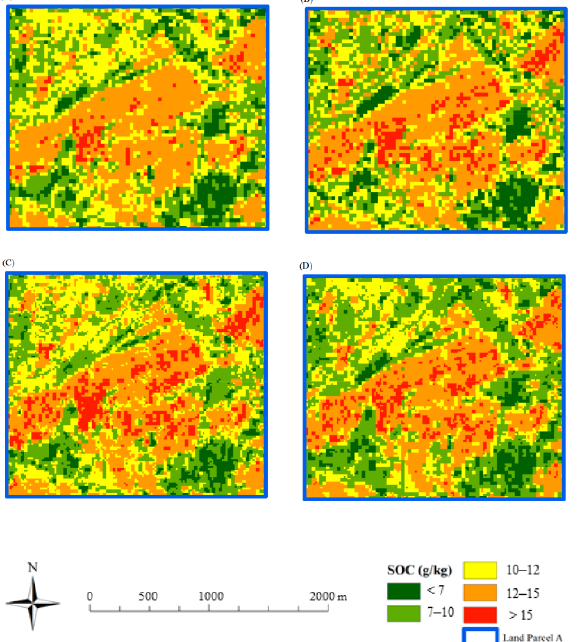
Figure 5. Spatial pattern of SOC in Land Parcel A based on ( A ) the LT model; ( B ) the LTb model; ( C ) the LTi model; ( D ) the LTg model. ( C ) the LTi model; ( D ) the LTg